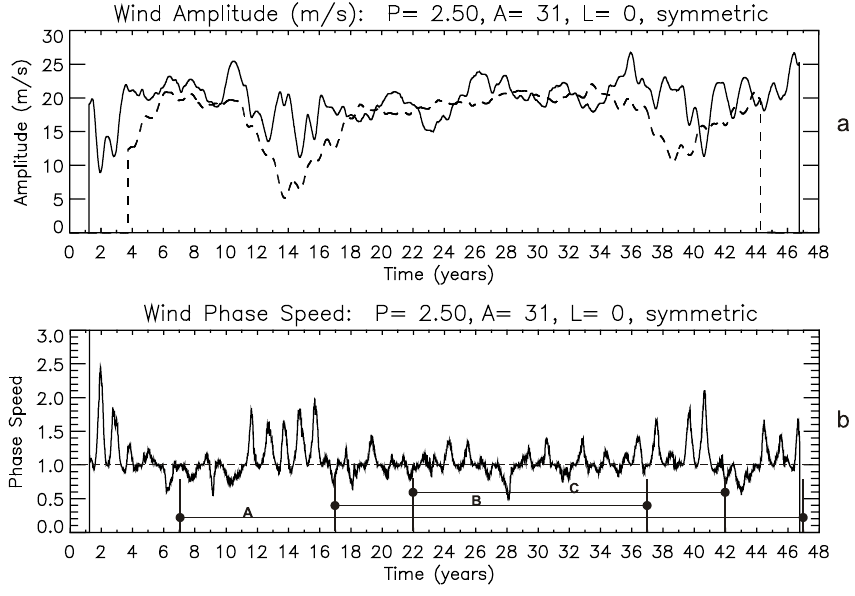
Fig. 2. (a) Amplitude of 30-month (2.5-year) symmetric QBO at 31km and 0 degrees latitude, computed from a moving window displaced by one day. Solid line for the first harmonic with 30-month window; dashed line for the third harmonic with 90-month window. As expected, the 3rd harmonic amplitudes tend to be smaller. (b) Effective “phase speed” for the moving 30-month window normalized to one as discussed in the text. Deviations from one are a measure of the variability for the oscillation period. It shows that the QBO is highly variable during the first 5 years, then again between 12 and 16 years, and again after 37 years. The most stable time interval is between about 17 and 37 years, labeled B, and it is discussed in Fig.